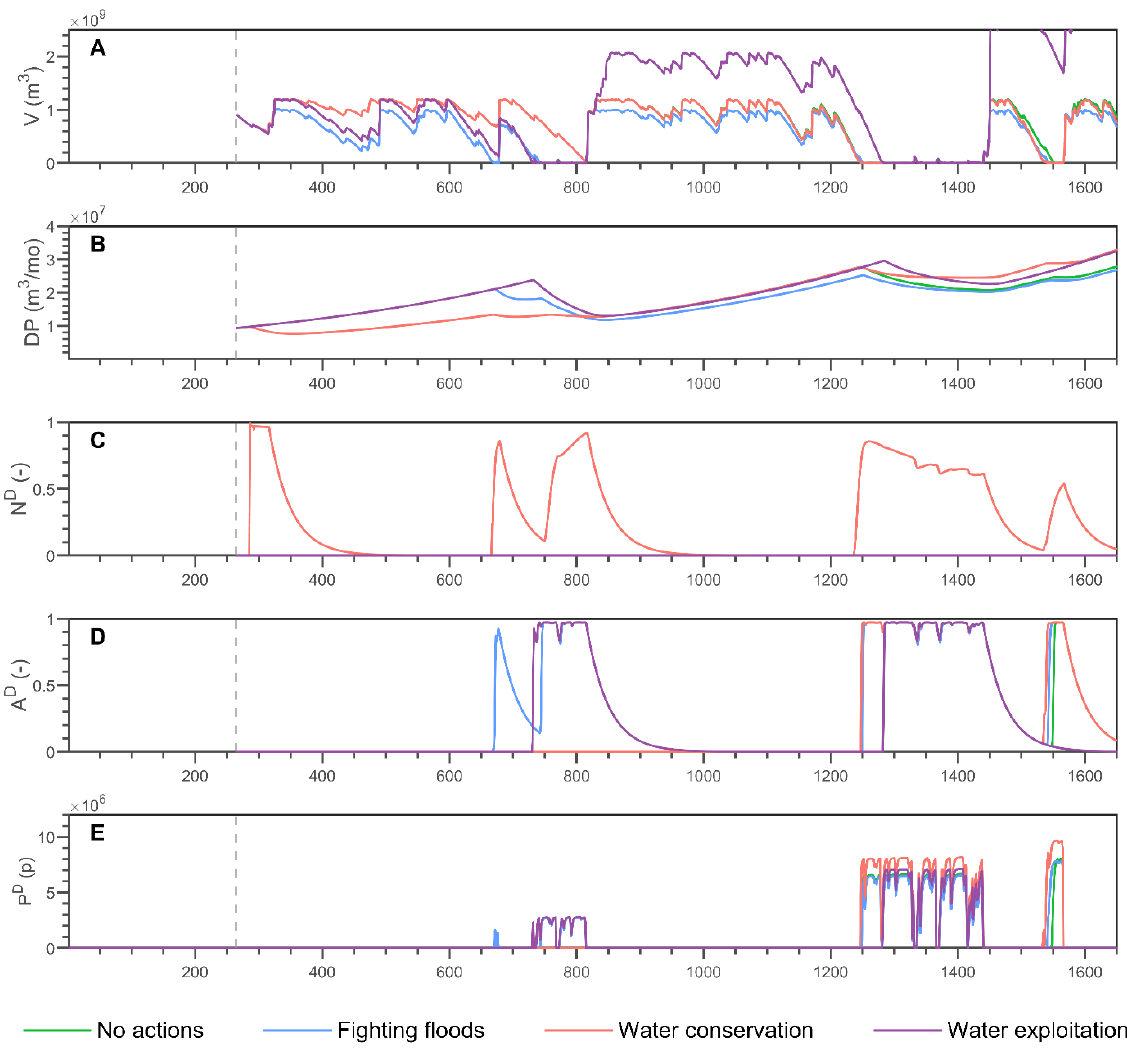
Figure A11. Water shortage-based variables of the synthetic experiments additional scenario #2 considering dam construction and human-flood interactions with the four water management strategies introduced in this study. (A) reservoir volume (V), (B) total water demand (DP), (C) willingness to the new per-capita demand (ND), (D) drought awareness (AD), and (E) population affected by droughts (PD). The grey dashed line indicates the construction of the Wivenhoe